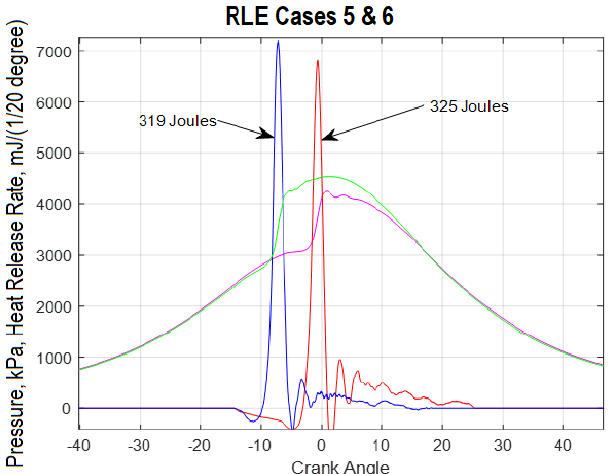
Figure 16. Instantaneous heat release rate for RLE Case 5 (blue/green) and Case 6 (red/purple). One interesting observation in Figure 9 is that the approximately 4 degrees of physical rotation of the mechanical injection pump generated about 6 degrees of delay in the premixed combustion